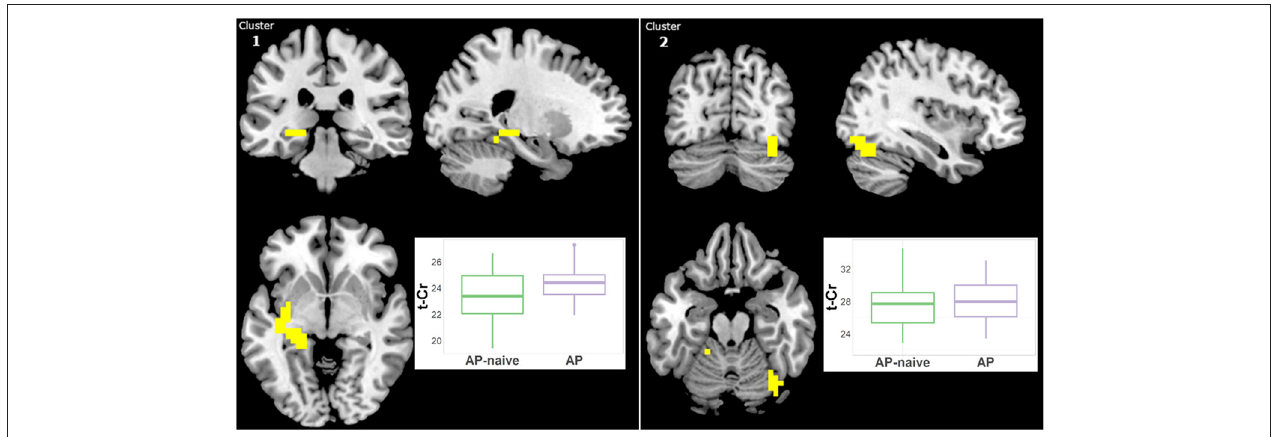
FIGURE 6 | Increased t-Cr in antipsychotic treated (AP) vs. antipsychotic naïve (AP-naive) Schizophrenia in two clusters: (1) 34 voxels (CCLAV = 0.02), including the left parahippocampal gyrus (25.0%) and left culmen (10.5%). (2) 27 voxels, CCLAV = 0.03, including the right declive (51.9%) and the right fusiform gyrus (16.5%). Boxplots show weighted-average t-Cr cluster concentrations in institutional